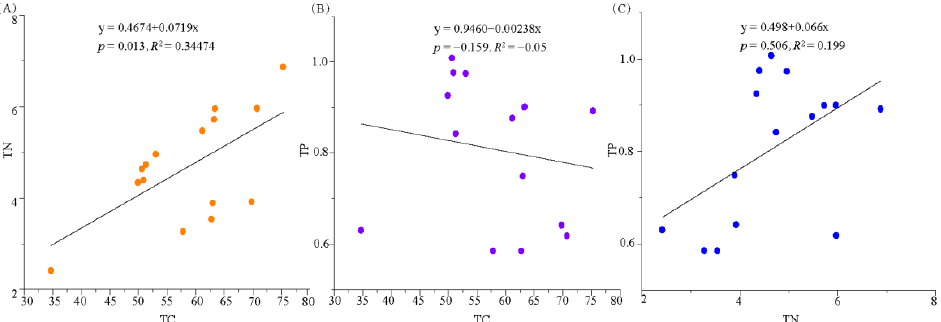
Figure 4. Correlation between soil total carbon and nitrogen ( A ), soil total carbon and phosphorus ( B ), and soil total nitrogen and phosphorus ( C ). Table 3. Stoichiometric vector analysis of three planting cover types of soil. Different lowercase letters indicate significant differences according to Duncan’s test ( p <